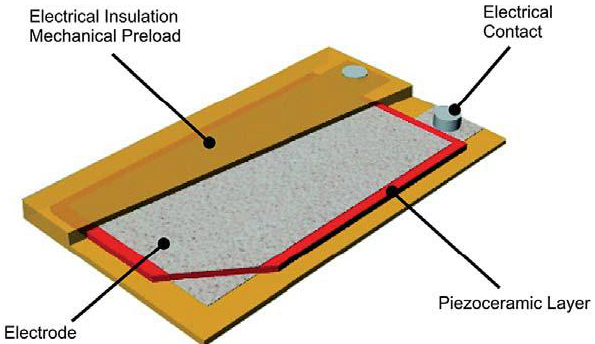
Figure 1. Design principle of the DPT transducer. Published courtesy of PI Ltd.